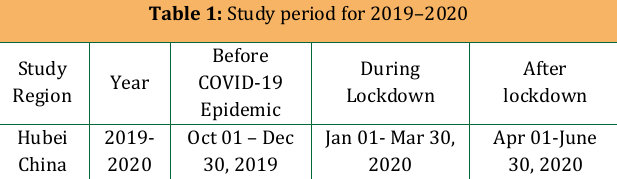
Table 1: Study period for 2019 – 2020